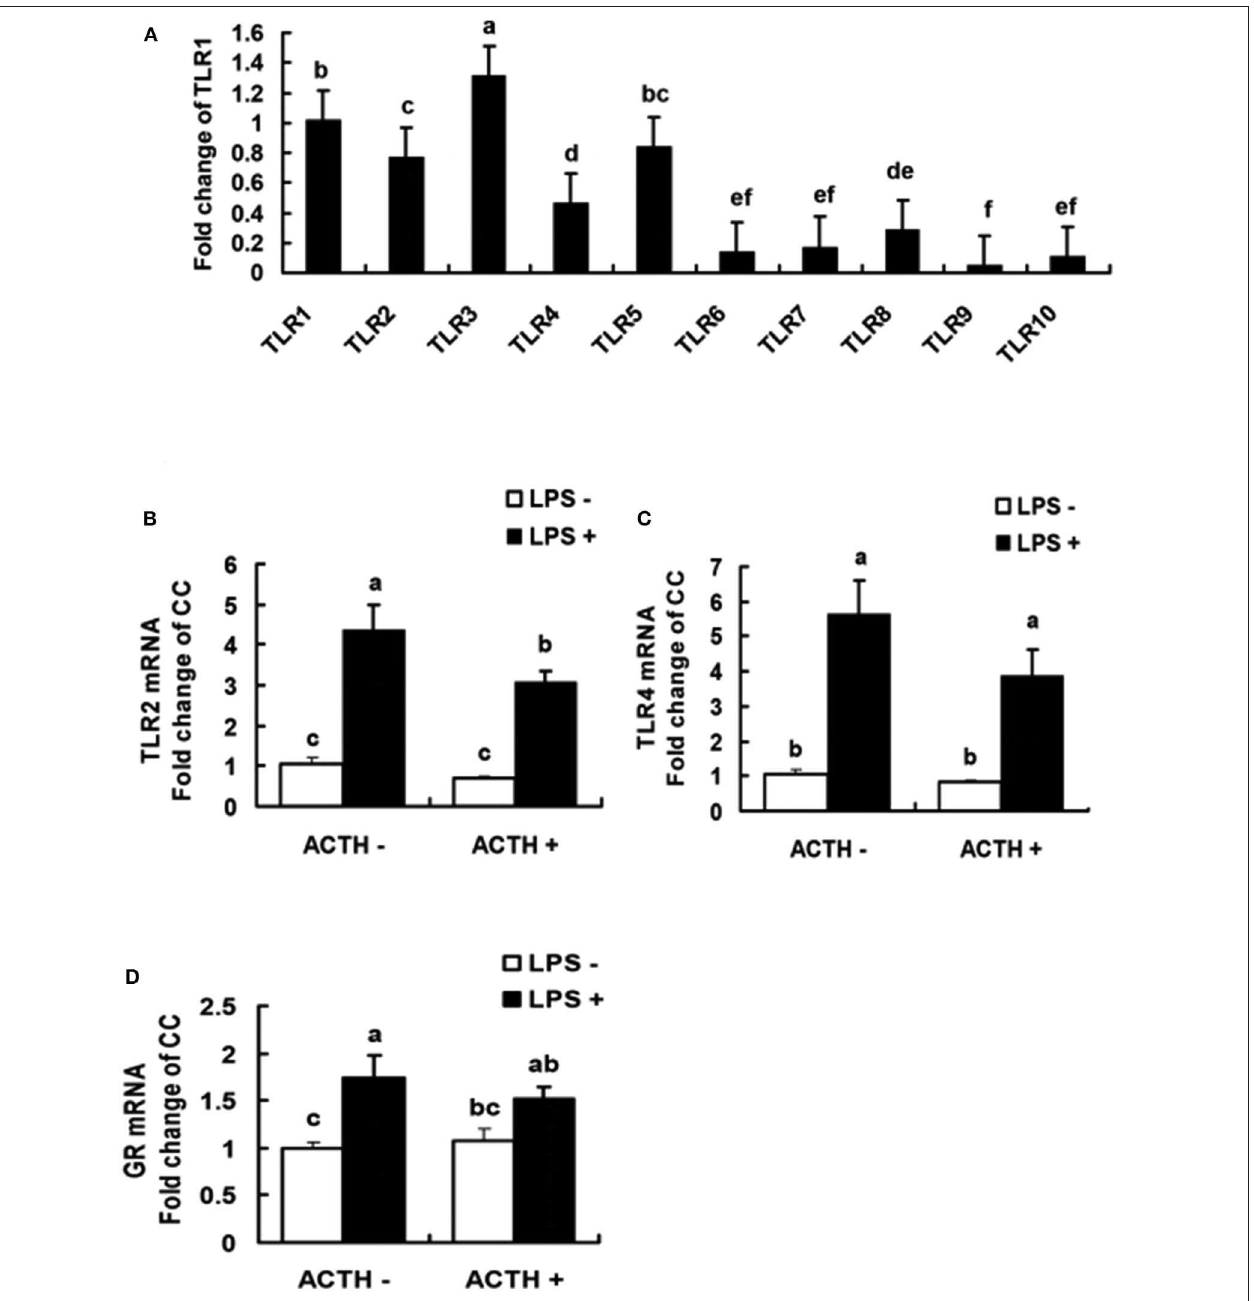
FIGURE 3 | Levels of TLR mRNA in normal porcine adrenal tissue (A) , and effects of lipopolysaccharide/ACTH on mRNA expressions of TLR2 (B) , TLR4 (C) , and GR (D) in local porcine adrenal gland tissue. Means with different letters (a, b, c, d, e, f) are significantly different ( P < 0.05) from each other, n = 5–6. Different superscript letters indicate significant differences between the same column. Data are expressed as mean ± SEM